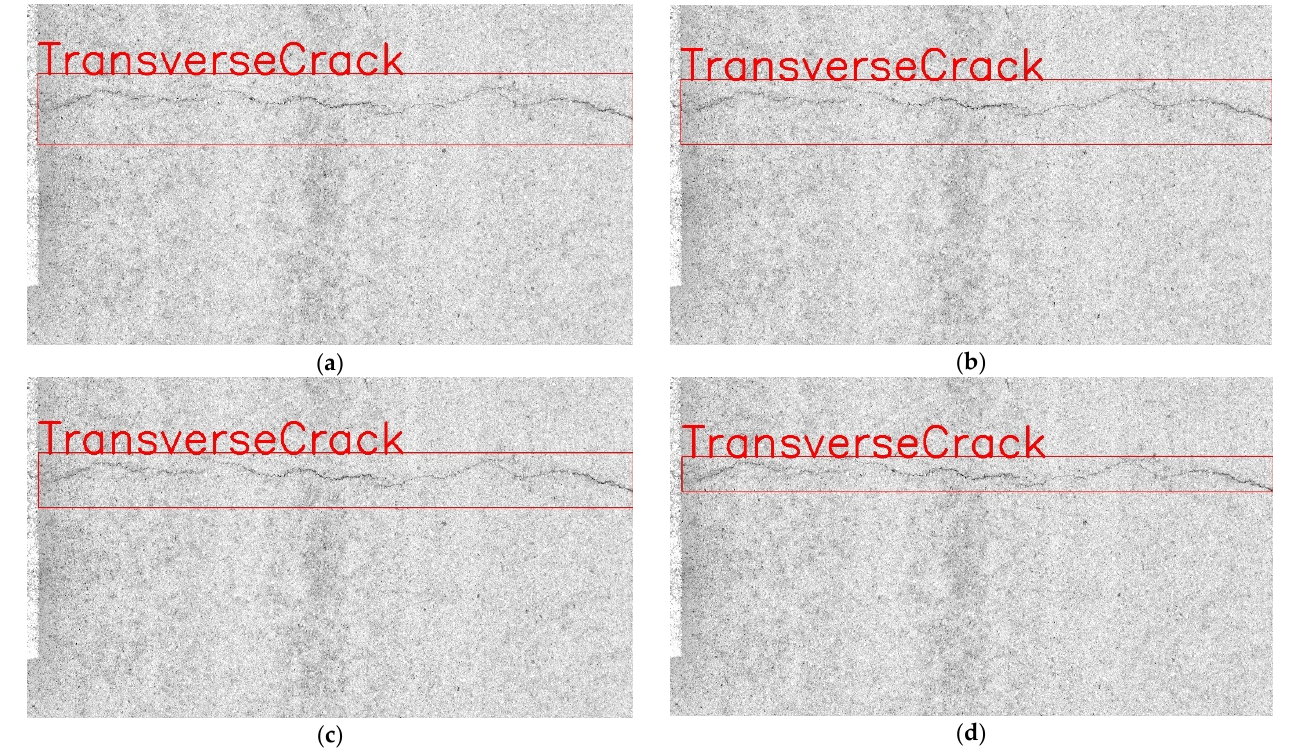
Figure 18. Detection results under different loss functions. ( a ) Baseline + SimAM + Transformer + GIoU. ( b ) Baseline + SimAM + Transformer + DIoU. ( c ) Baseline + SimAM + Transformer + CIoU. ( d ) Baseline + SimAM + Transformer + SIoU.